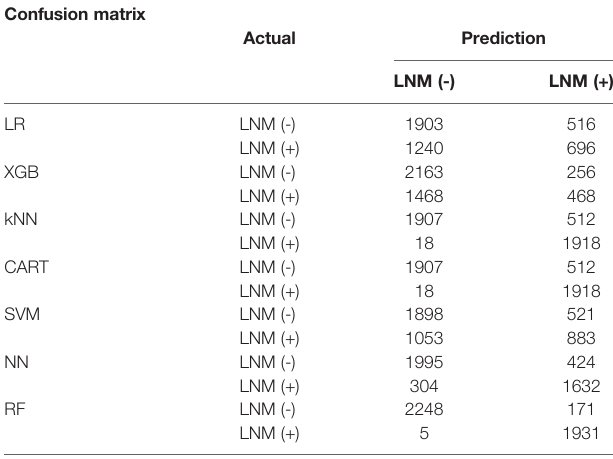
FIGURE 2 | Evaluation of the predictive models. (A) AverageROC curves of seven models. (B) Average PR curves, indicatingthe tradeoff between precision and recall. TABLE 2 | Confusion matrices of developed models.